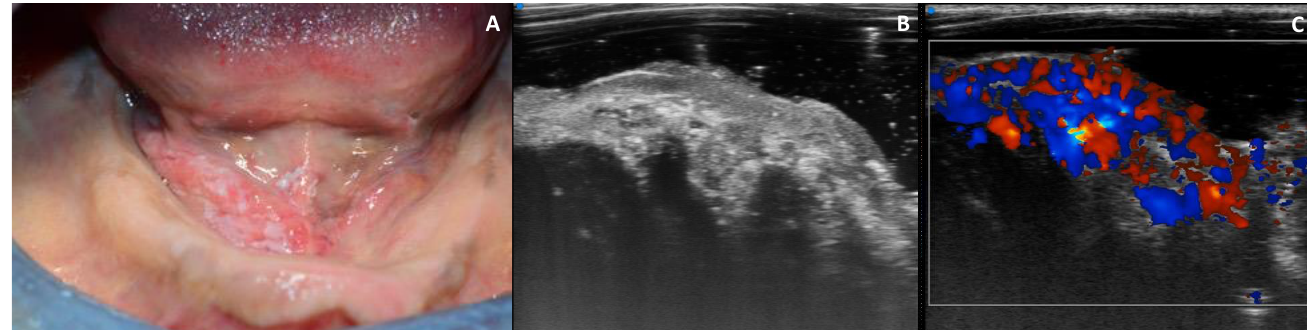
Figure 2. OSCC of the buccal mucosa in a 58-year-old female: ( A ) clinical aspect of the lesion; ( B ) B-mode UHFUS (ultra- high frequency ultrasound) examination, showing a hypoechoic exophytic lesion with irregular margins; the underlying submucosa appears to be thinned; ( C ) color Doppler image, showing moderate (score 2) intralesional vascularization.